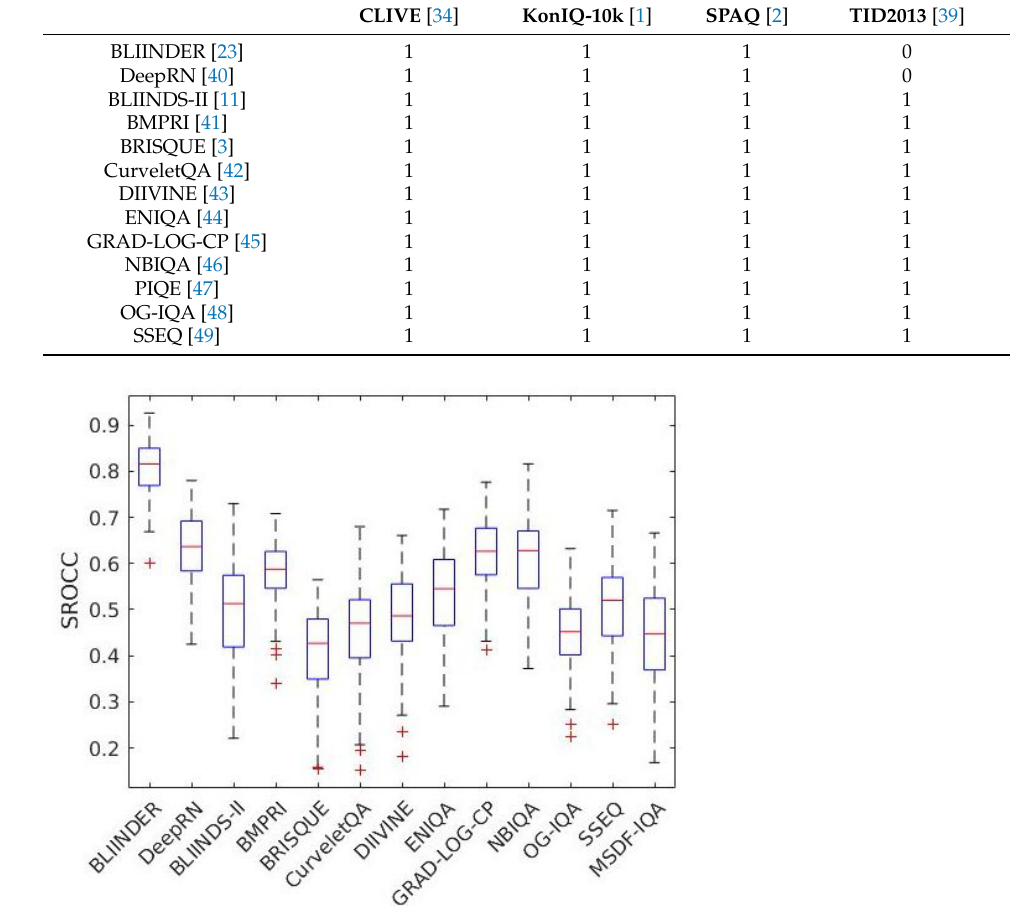
Figure 5. Boxplots of measured SROCC values on TID2013 [39]. The examined NR-IQA algorithms were evaluated over 100 random train–test splits with respect to the reference